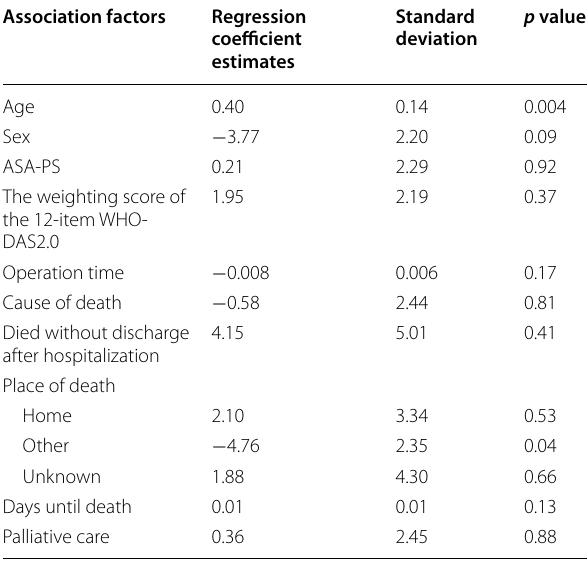
Table 4 Multiple regression analysis of the factors contributing to the Good Death Inventory (GDI)